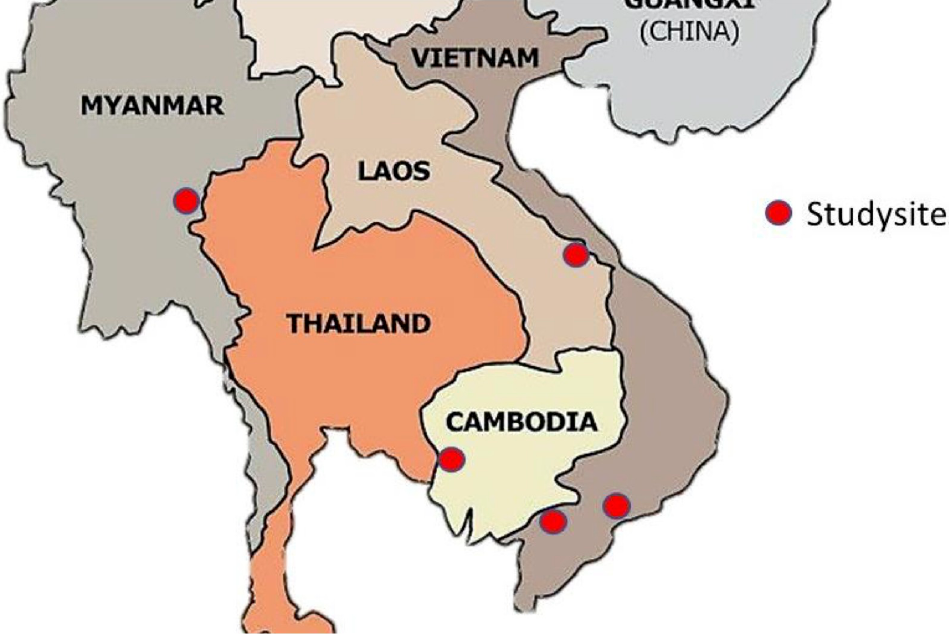
Fig 1. Targeted malaria elimination study sites in Myanmar, Cambodia, Laos and Vietnam.